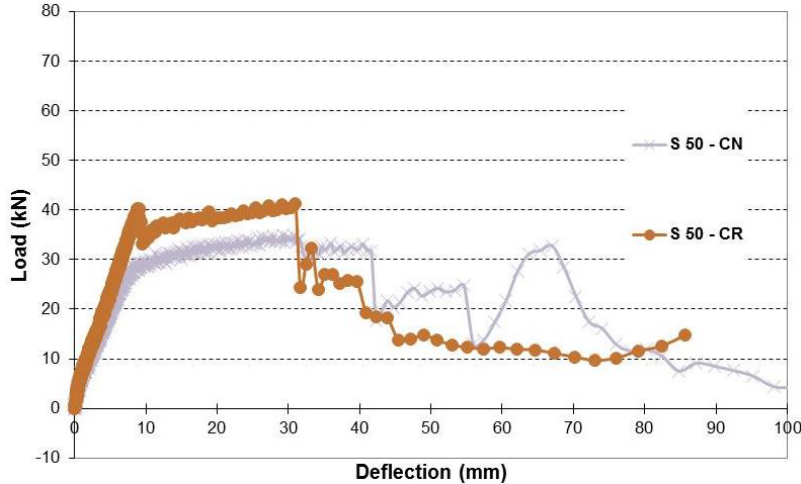
Figure 12. Load-deflection relationship of beams with simulated 50% corrosion level.